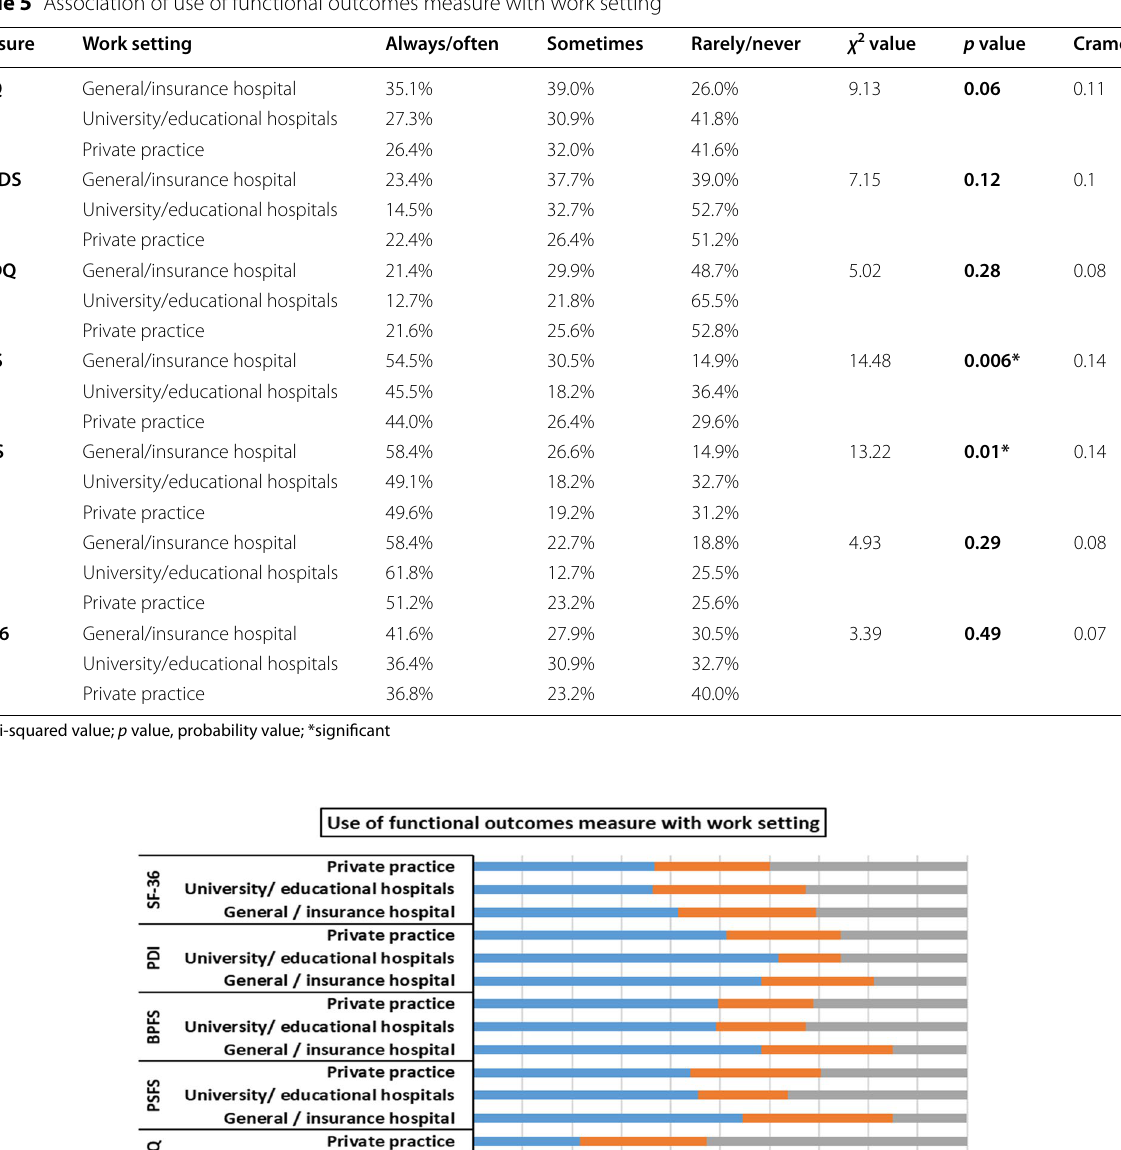
Table 5 Association of use of functional outcomes measure with work setting